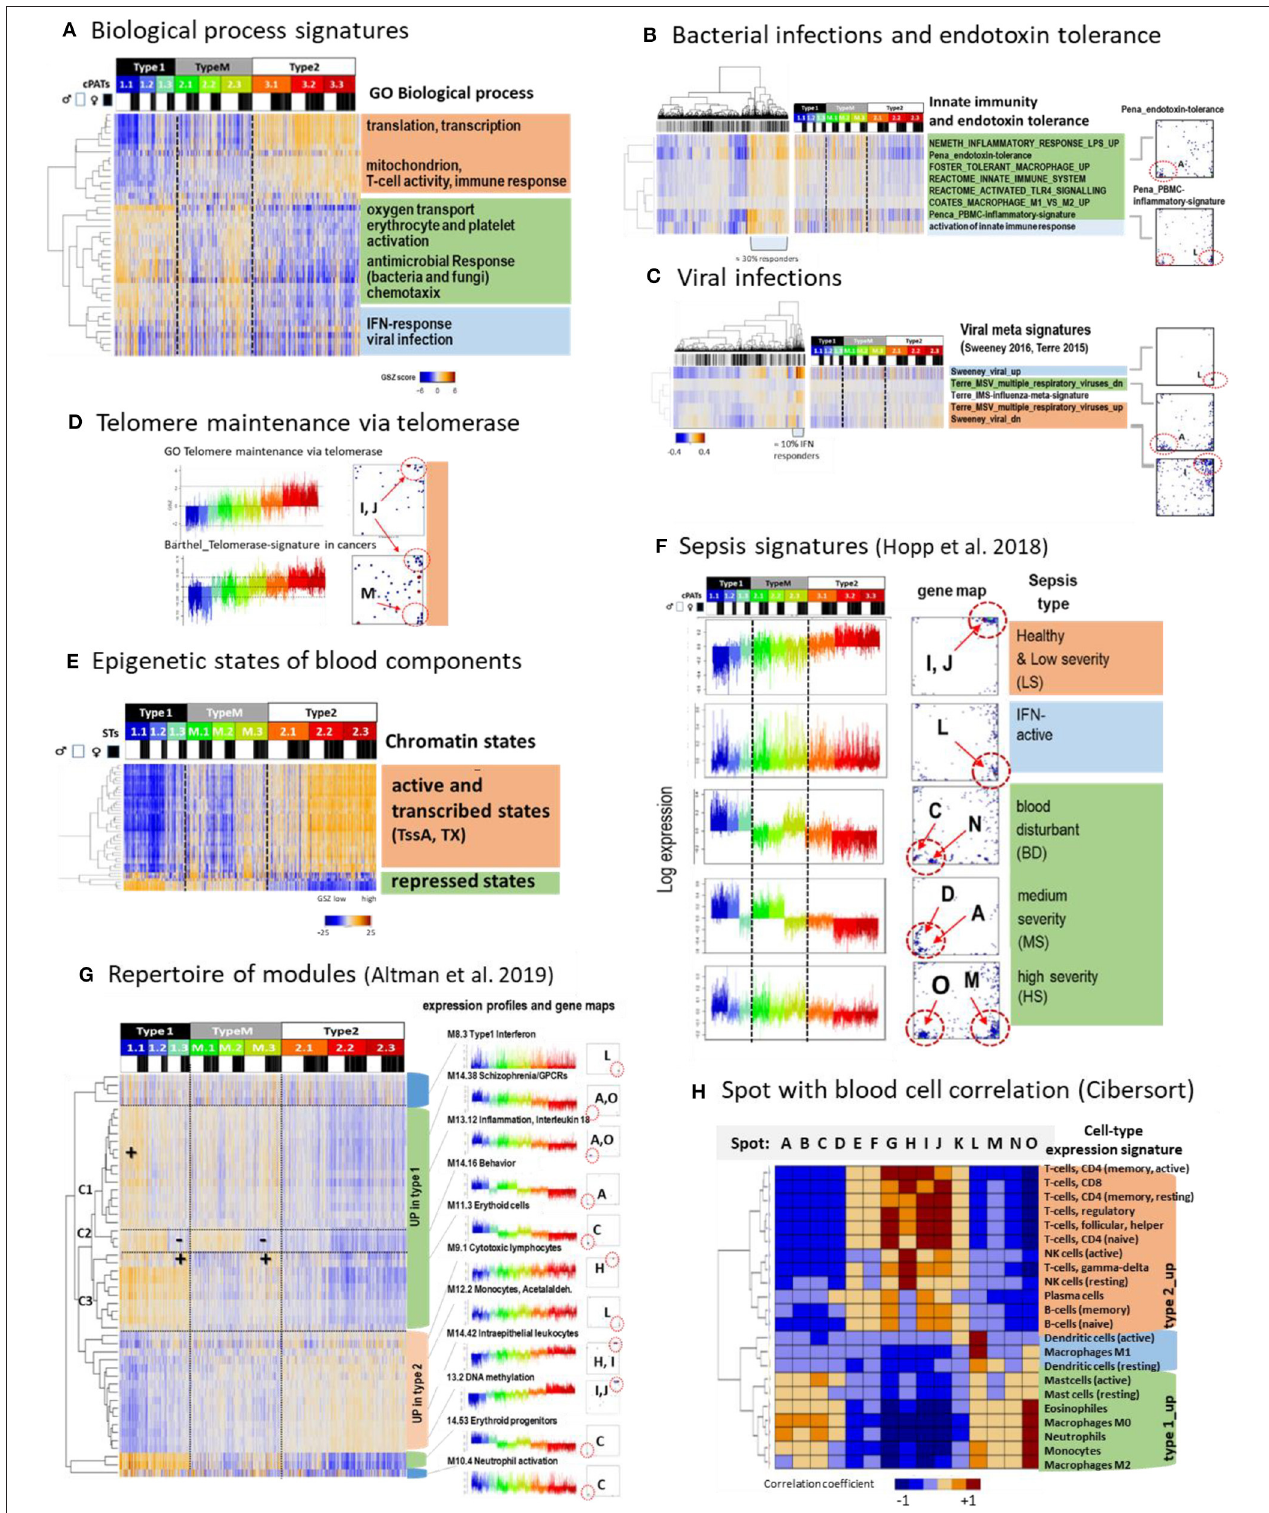
FIGURE 4 | Functional characteristics and previous signatures of the blood transcriptome: (A) Signatures of the GO-term biological process (BP) roughly group into processes upregulated in type 1 (green), type 2 (apricot color), and in samples showing high expression in all types (blue) (see also Supplementary Figure 7 ). (B)